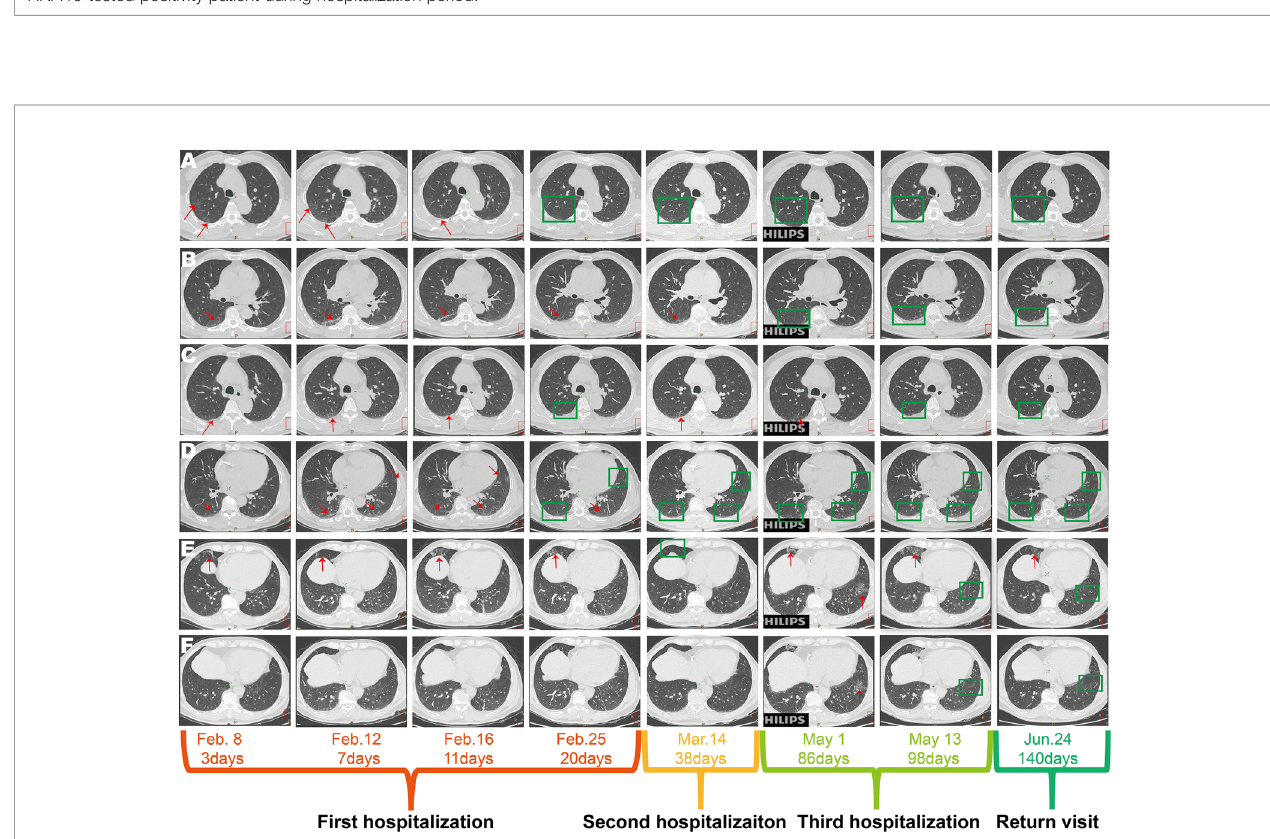
FIGURE 2 | Chest computed tomography scans of the COVID-19 patient with SARS-CoV-2 RNA re-tested positivity during the hospitalization period. (A) The ground-glass opacities in the upper part of the posterior segments of the right upper lobe. (B) The ground-glass opacity in the posterior segments of the right lower lobe. (C) The ground-glass opacity in the lower part of posterior segments of the right upper lobe disappeared in the fi rst hospitalization, re-appeared in the second and third hospitalization (the fi rst recurrent SARS-CoV-2 RNA positive and the second recurrent SARS-CoV-2 RNA positive). (D) The ground-glass opacity in the right upper lobe, left lower lobe, and lingual segment of the left upper lobe. (E) The lesion of the right middle lung displayed as patchy, ground-glass and linear lesion during the fi rst hospitalization, disappeared during the second hospitalization, re-appeared and was enlarged during the third hospitalization, but was absorbed on the return visit (June, 24, 2020). (F) Appearance of the ground-glass opacity in the basal segment of the left lower lung near the diaphragmatic dome at third hospitalization (the second recurrent SARS-CoV-2 RNA positive).